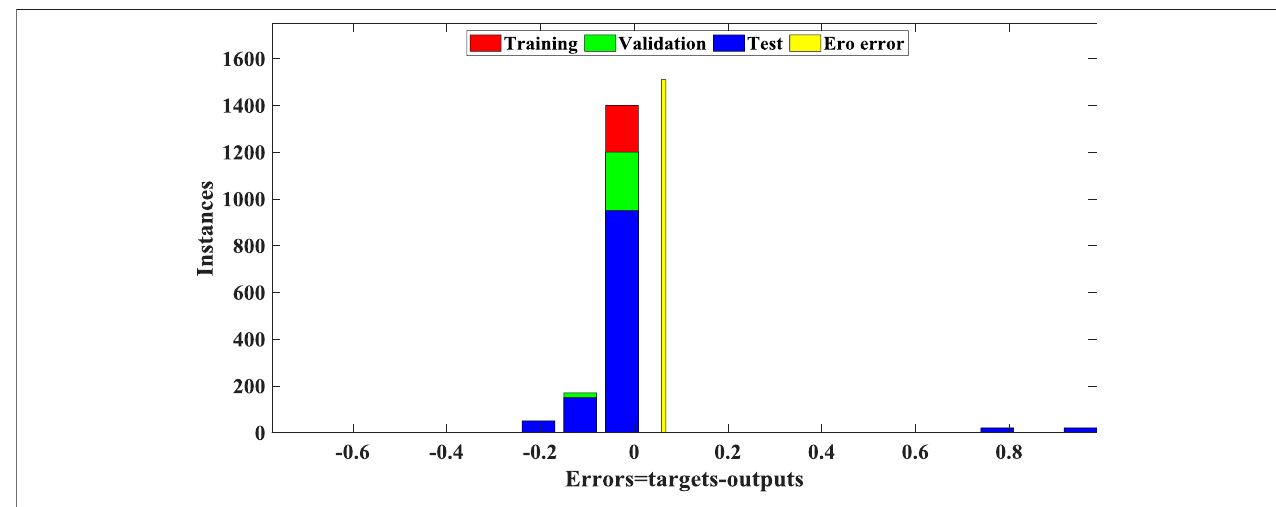
FIGURE 7 | Training error histogram, con fi rmation, and testing with the GWA – ANN.